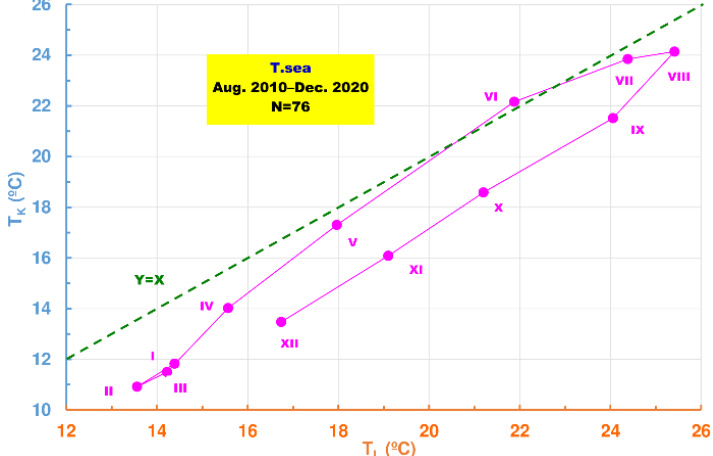
Figure 11. Relationship between the average values of the mean monthly sea surface temperatures at Krk (ordinate axis) and Lastovo (abscissa axis) from July 2010 to December 2020, for the months (I – XII) when measured at both stations.